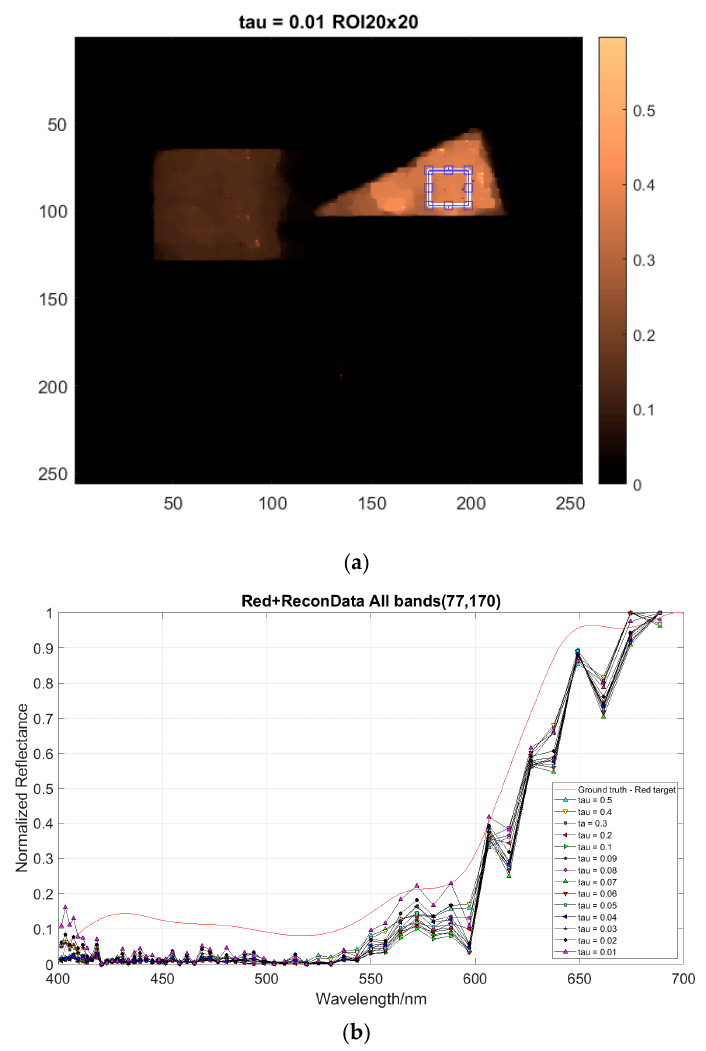
Figure 13. The effect of reconstruction for ( a ) the red triangle target using a range of ( b ) the regularizer parameter τ 0.01–0.5. The smaller the values of τ (e.g., 0.02 and 0.01) give better spectral reconstruction